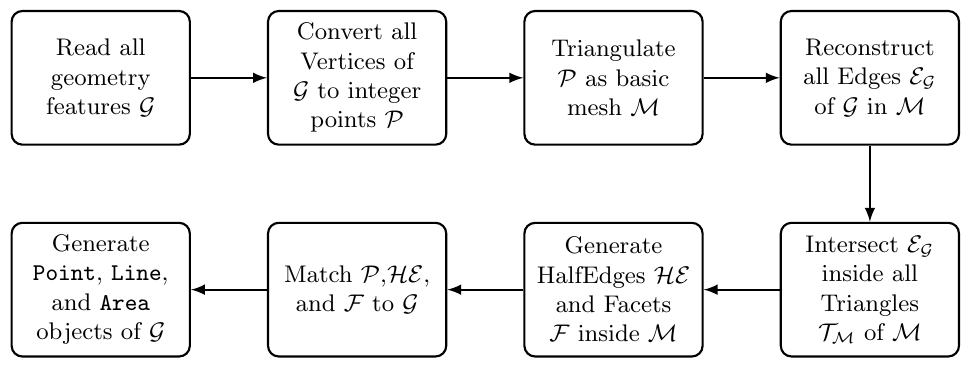
Figure 2. Steps to prepare the geometric features.